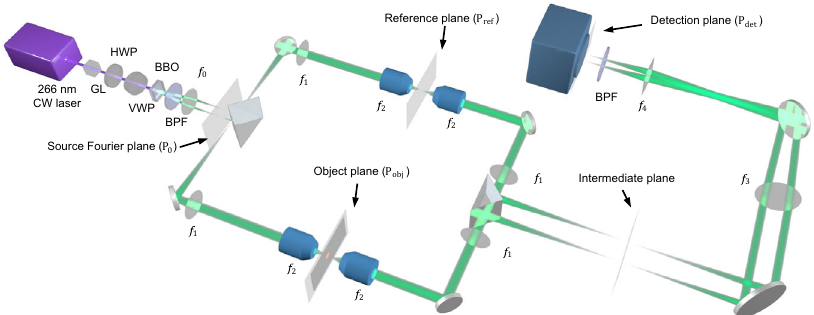
Fig.1|ExperimentalsetupofQMC. CWcontinuouswave,GLGlan-Laserpolarizer, HWP half-wave plate, VWP variable wave plate, BBO β -barium borate crystal, BPF 532nm bandpass fi lter, PBS polarizing beam splitter, EMCCD electron multiplying